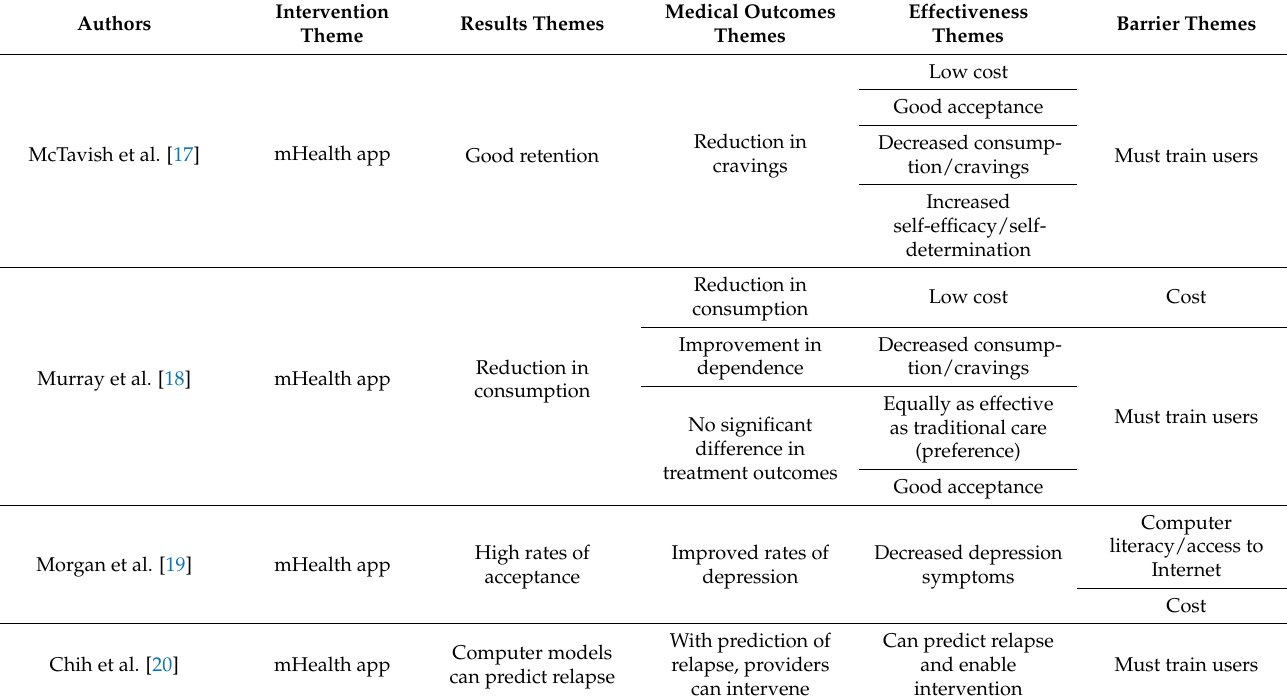
Table 2. Summary of analysis, sorted most